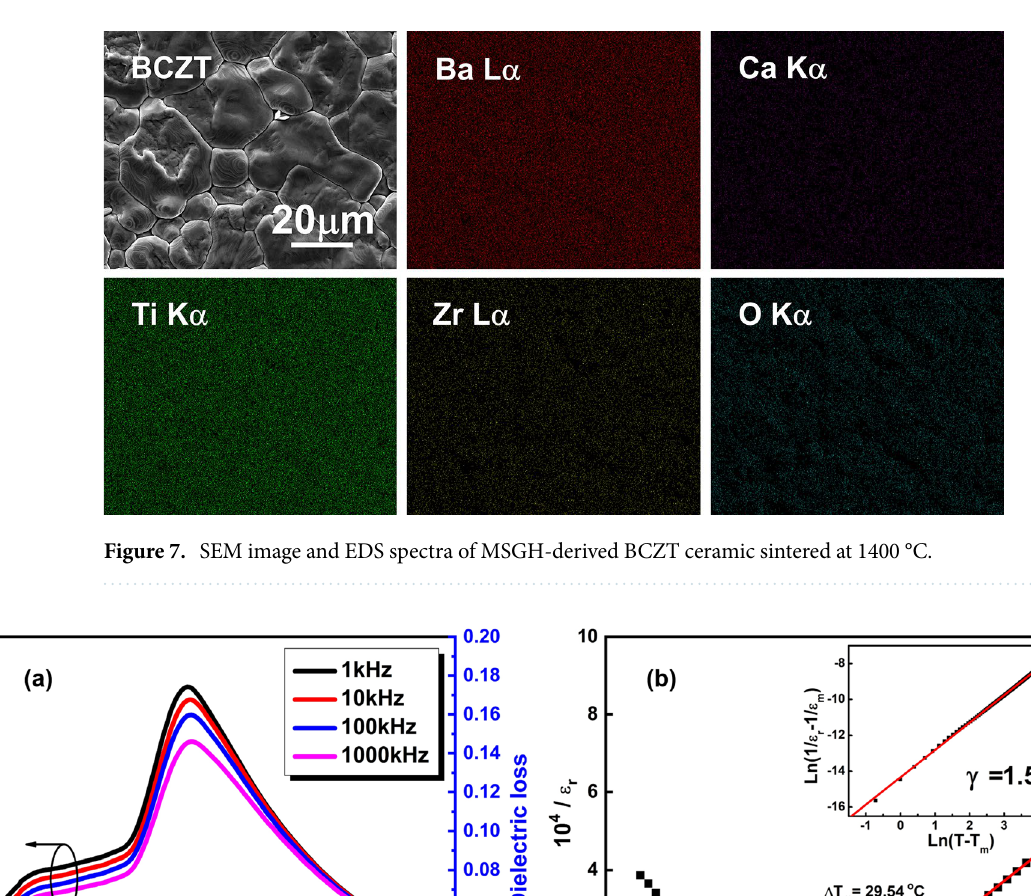
Figure 6. Raman spectra of MSGH derived BCZT ceramic sintered at 1400 °C.